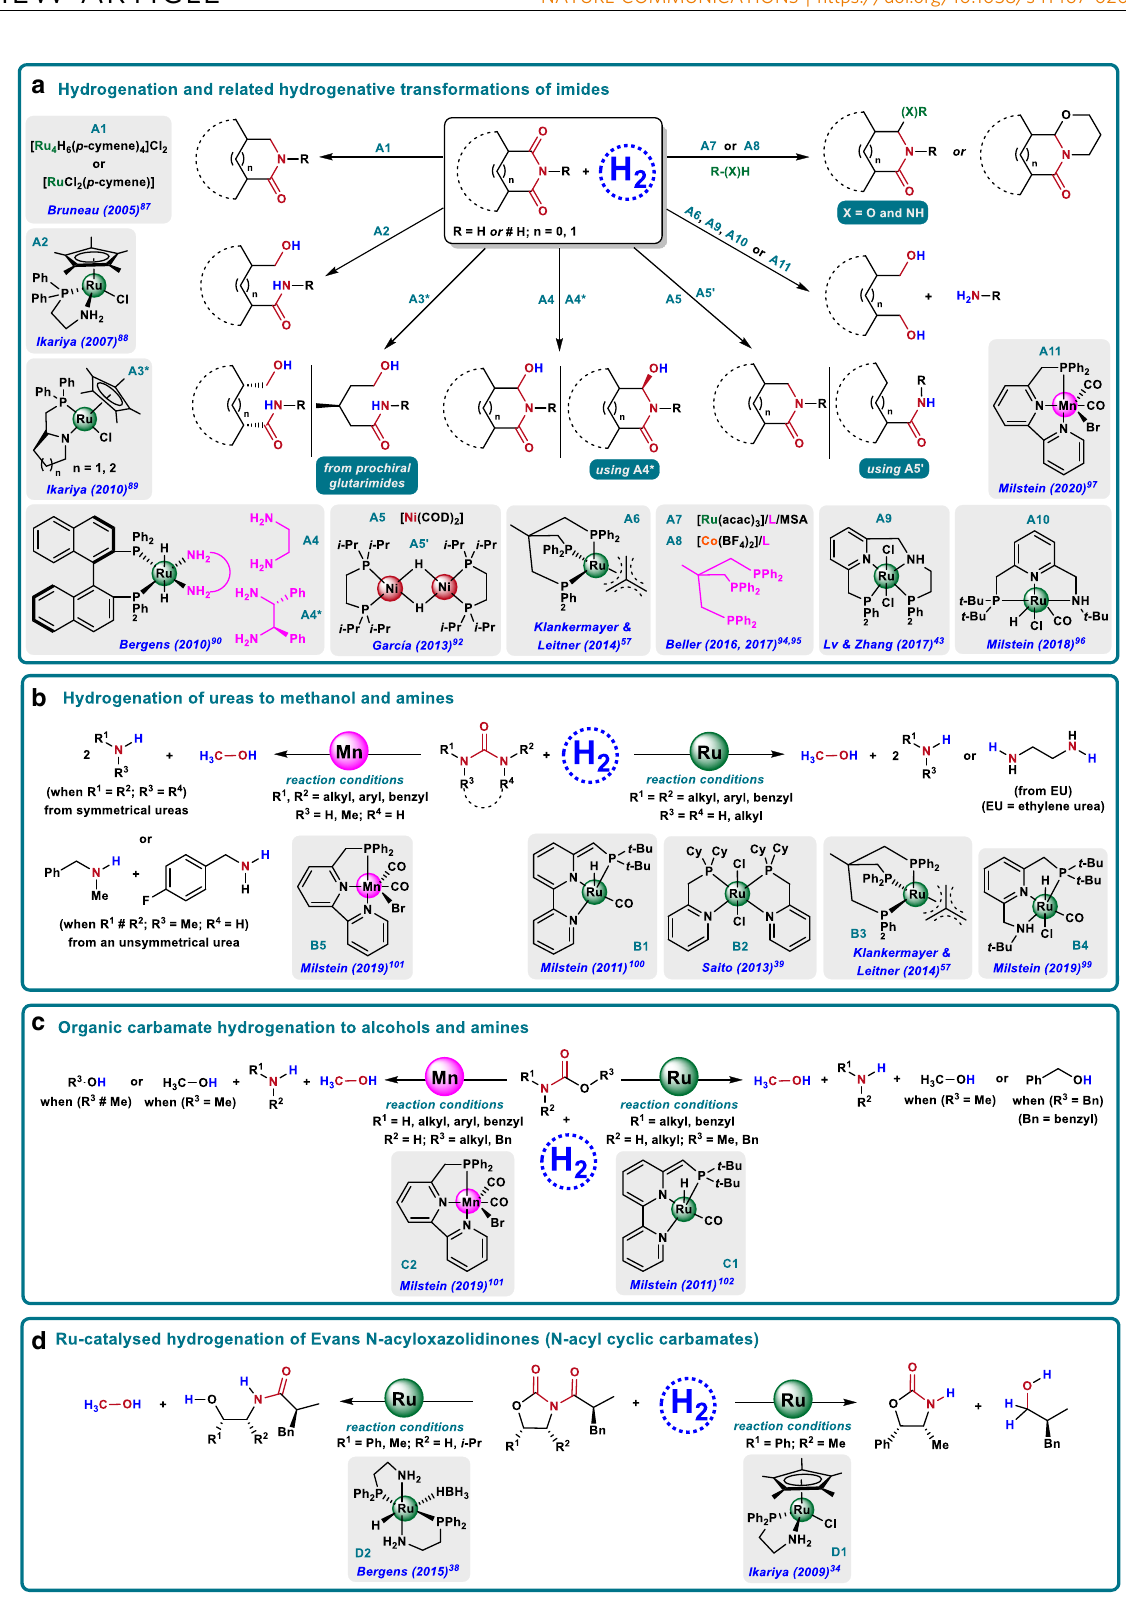
Fig. 4 Homogeneously catalyzed hydrogenation of amide-related compounds. a Hydrogenative transformations of imides. b Ureas to methanol and amines. c Organic carbamates to alcohol and amines. d N -acyloxazolidinones to valuable